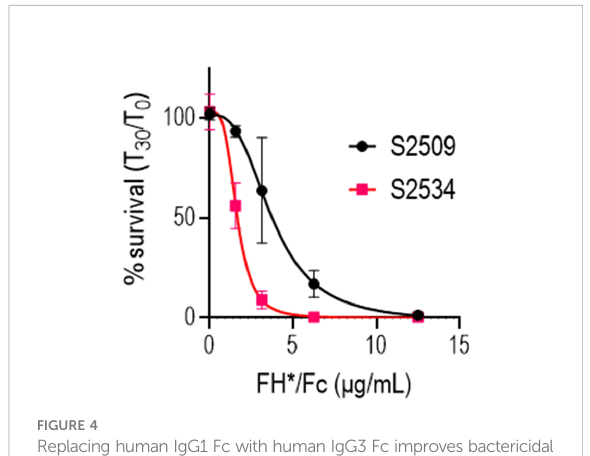
FIGURE 4 Replacing human IgG1 Fc with human IgG3 Fc improves bactericidal activity of FH*/Fc. N. gonorrhoeae FA1090 was incubated with increasing concentrations (indicated on the X-axis) of S2509 (Fc1/ FH*) or S2534 (Fc3/FH*) and human complement (IgG/IgM depleted human serum) and survival at 30 min was measured (Y-axis). The mean (range) of 3 experiments is shown.